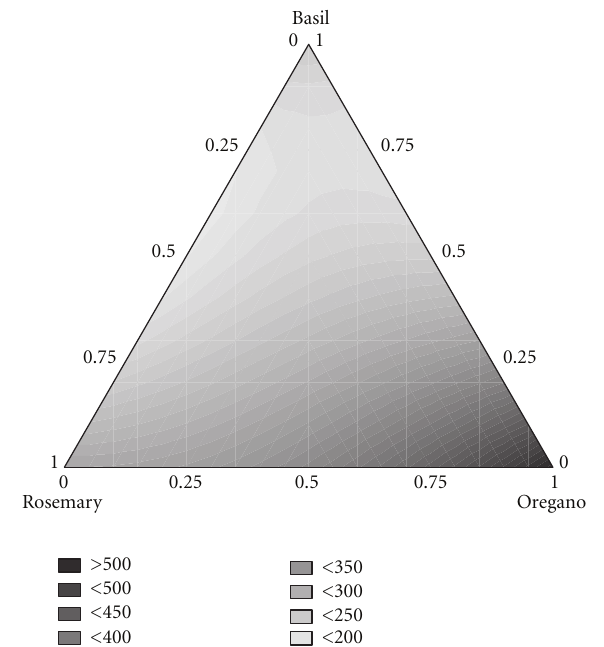
F 4: Response Surface for Storage Time determined by accel- erated stove method.